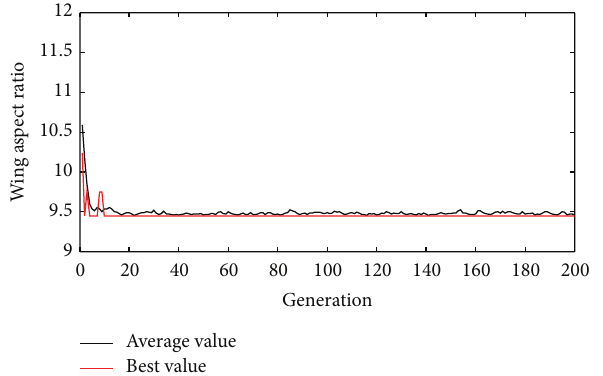
Figure 7: Best and average horizontal tail area (m 2 ) versus genera- tion.